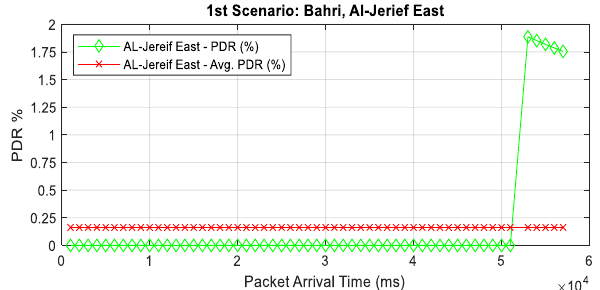
Fig. 6 PDR and received packets as a function of time (1st